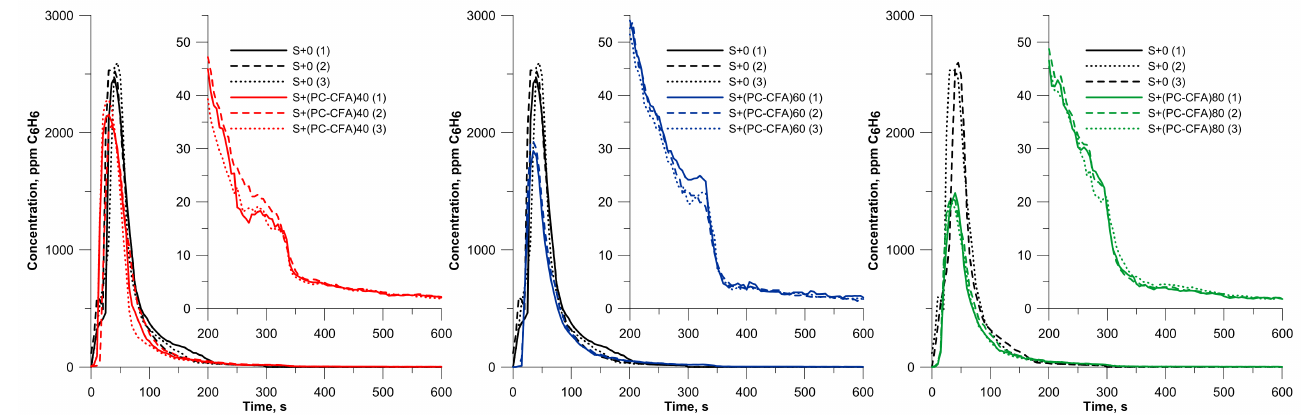
Figure 3. Comparison of benzene emissions during the chemical solidification process of soil using cement-fly ash mixture. Code of the sample: S—soil, PC-CFA—Portland cement-coal fly ash mixture, 40/60/80—PC-CFA mixture dose expressed as a percent of soil mass, (1)/(2)/(3)—sample